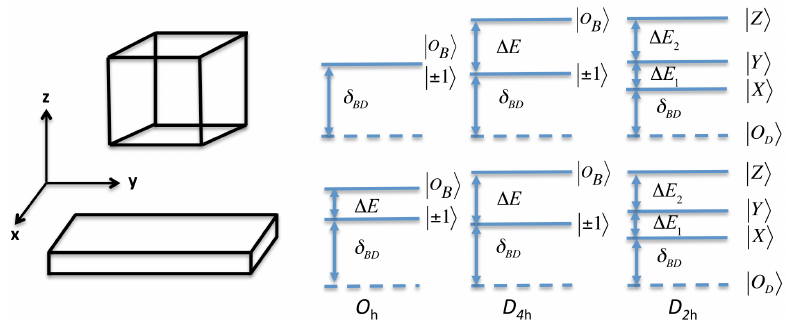
Figure 3. Energy labeling of the fine structure exciton states with cubic (O h ), tetragonal (D 4 h ), and orthorhombic (D 2 h ) symmetry, for ( top ) a cube-shaped NC and ( bottom ) a quasi-2D NPL. In O h symmetry, the three bright states are totally degenerate in a cube-shaped NC, while the degeneracy is partially lifted in the NPL. In tetragonal and orthorhombic symmetry, the FSSs have comparable